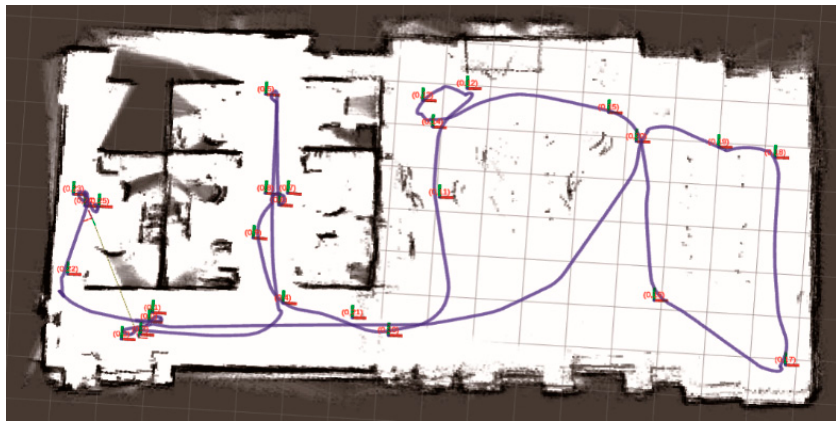
Figure 11. The trajectory of the robot during the experiment (shown as a purple line).